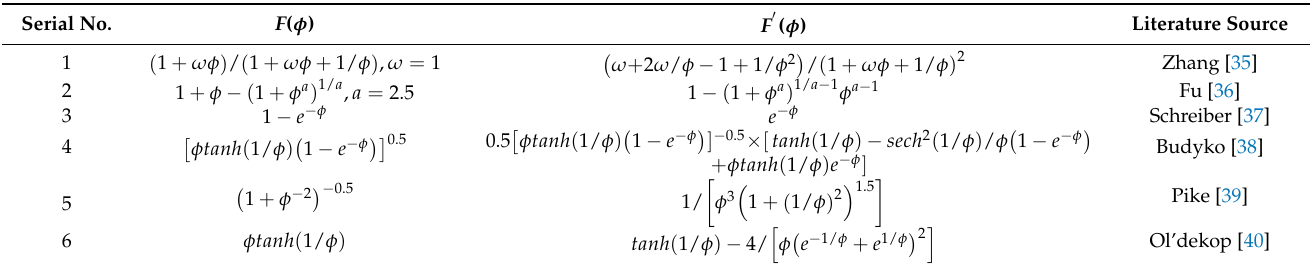
Table 2. Common expressions based on the Budyko